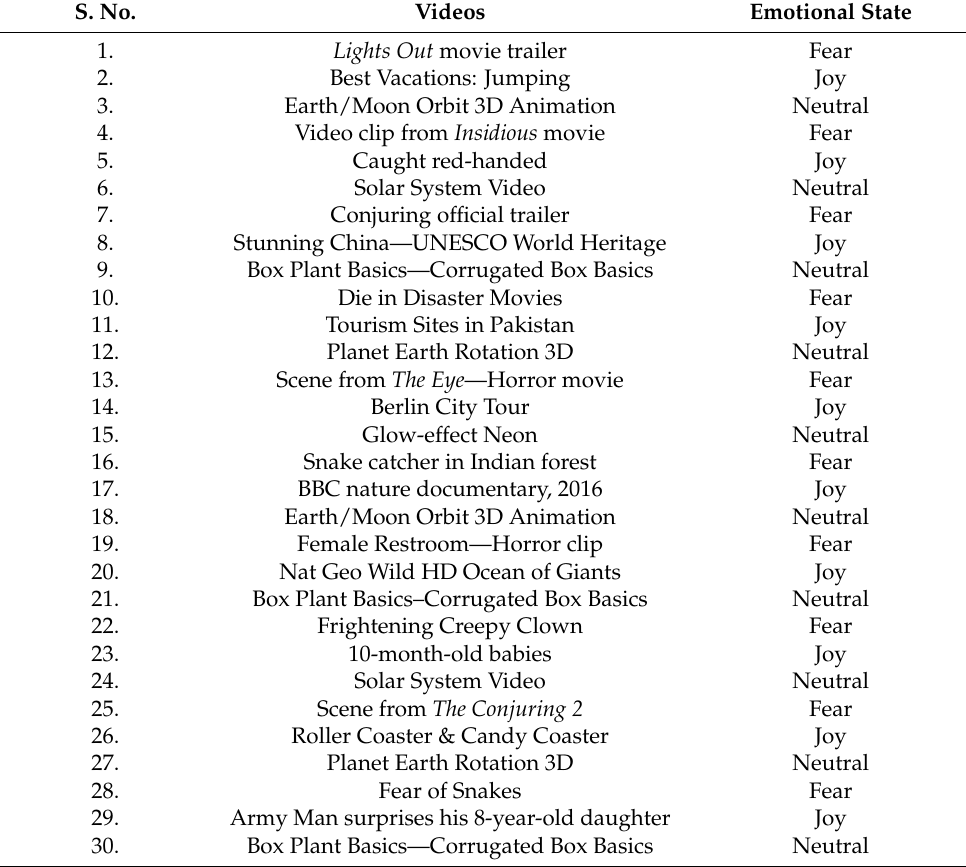
Table A1. List of videos shown to the participants